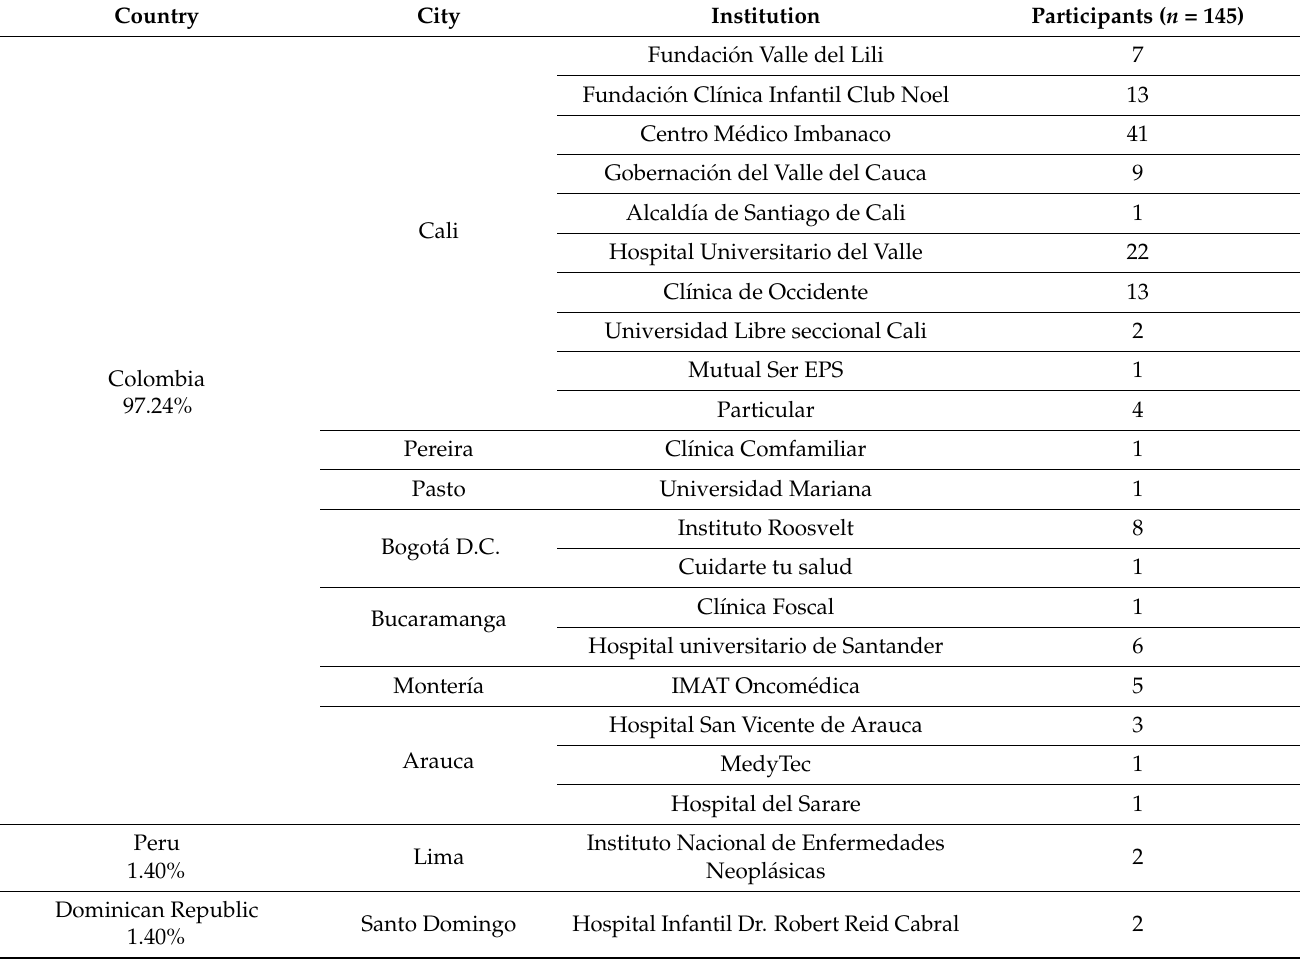
Table A2. Geographic distribution of participants.